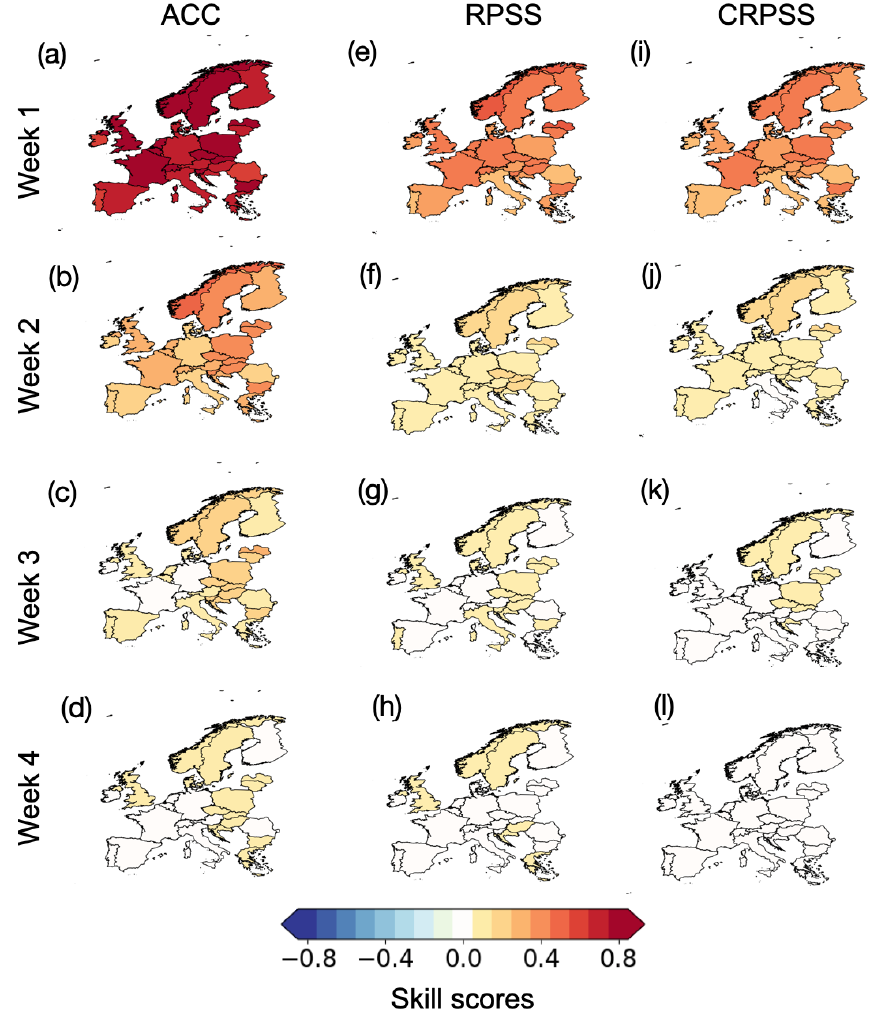
Figure 3. Country-level skill scores for weekly-mean demand-net-wind from the ECMWF model for (a–d) anomaly correlation coefficient, ACC; (e–h) rank probability skill score, RPSS (i–l) ; and continuous rank probability skill score, CRPSS. Definitions of skill scores are given in Sect.